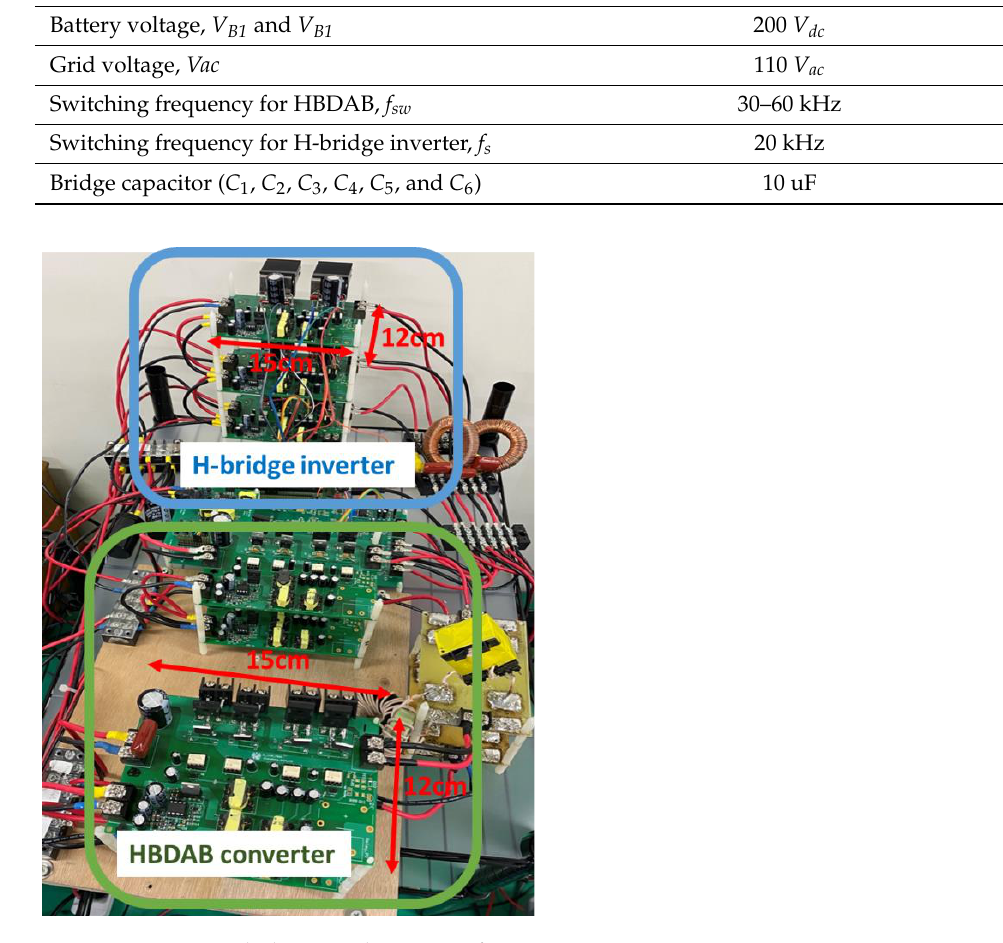
Figure 13. Prototype bidirectional converter for BESS.